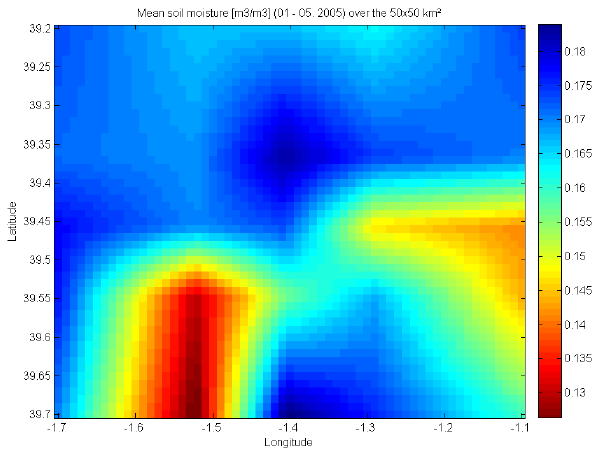
Fig. 7. Distributed soil moisture over the VAS 50 × 50km 2 area. Data represents the mean of soil moisture from 1 January to 30 April 2005.